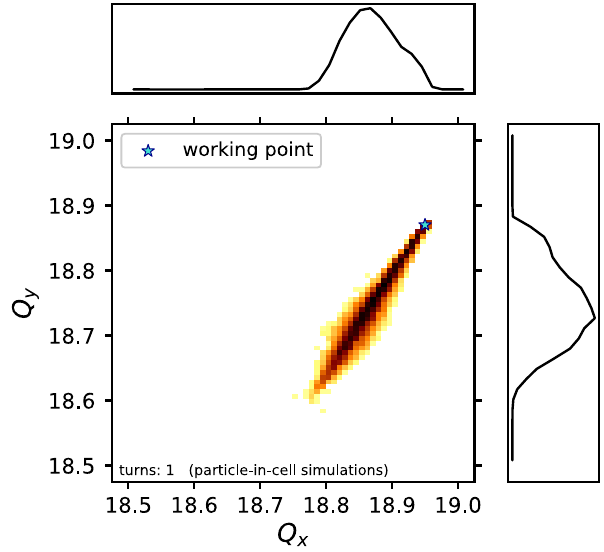
FIG. 1. Incoherent tune footprint of a SIS100 U 28 þ bunch at injection with space charge (using the 2.5D PIC space charge model) and natural chromaticity as tune spread